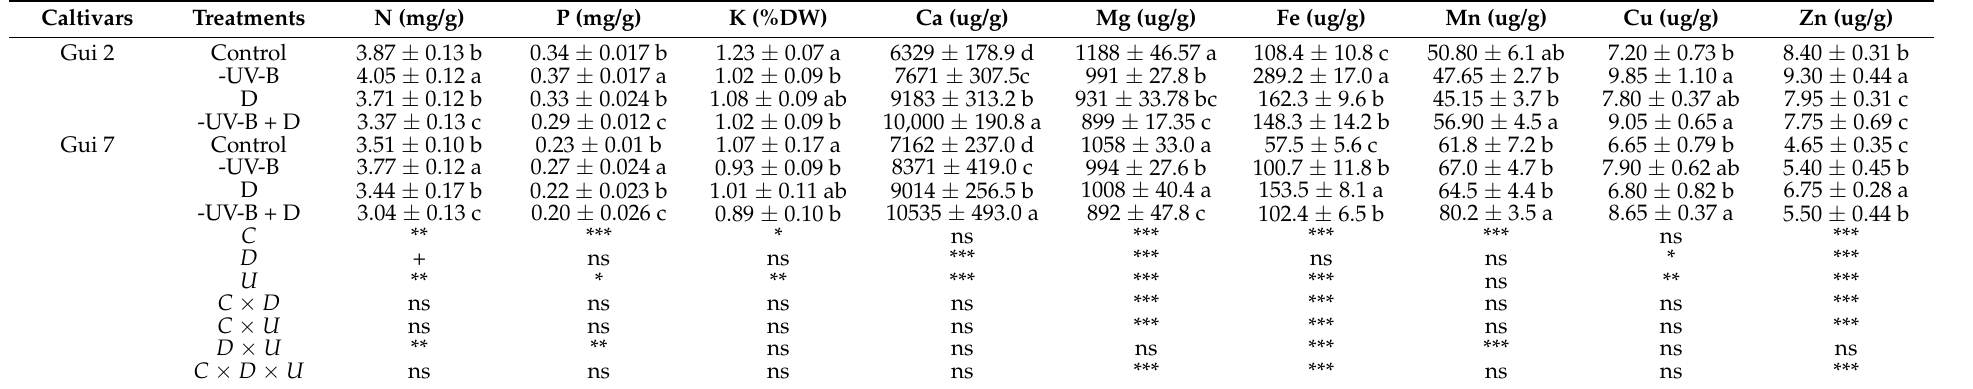
Table 2. The concentration of different nutrition elements of two Chestnut rose cultivars under different water regimes and UV-B treatments. Values shown are mean ± SD. Values within a column followed by the same letter do not differ significantly at p < 0.05 level by LSD pairwise comparisons. Control, ambient UV-B; –UV-B, UV-B exclusion; D, drought with ambient UV-B; –UV-B+D, drought with UV-B exclusion. Significance level (ANOVA): C, cultivar effect; D, drought effect; U, UV-B effect; C × D, cultivar × drought interaction; C × U, cultivar × UV-B interaction; U × D, drought × UV-B interaction; C × D × U, cultivar × drought × UV-B interaction. ns, not